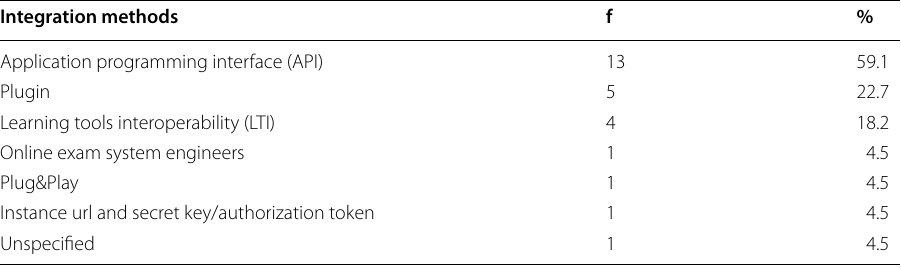
Table 12 Integration methods used in online assessment systems Integration